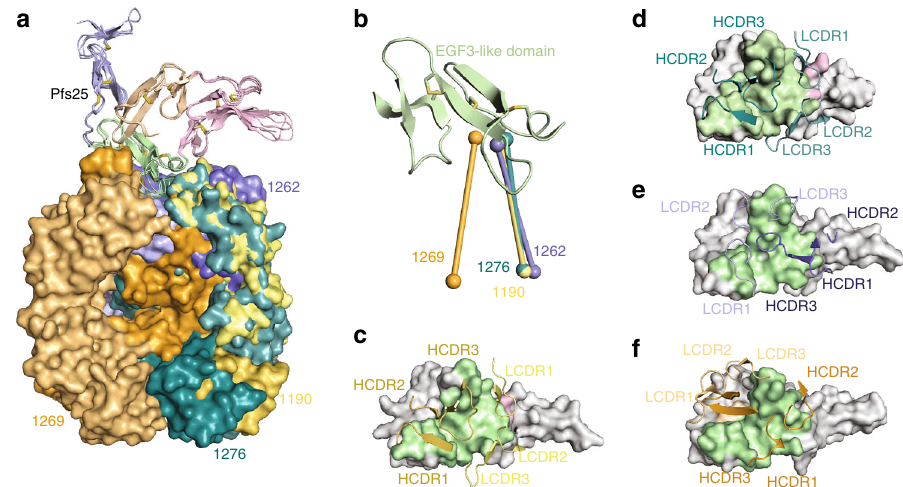
Fig. 4 Molecular details of site 1a antibody recognition. a Superposition of site 1a antibody – Pfs25 co-complex crystal structures. Pfs25 ’ s are shown as cartoon and colored according to EGF-like domain as in Fig. 3. 1190, 1262, 1269, and 1276 Fabs are shown as surface representation and colored in yellow, blue, orange, and teal, respectively. b Comparison of the angle of approach. The center of mass for both the Fab variable domains and interacting Pfs25 residues are shown as spheres and colored as in a . CDR loops that interact with Pfs25 for c 1190, d 1276, e 1262, and f 1269. Non-interacting Pfs25 residues are colored gray, while interacting residues are colored according to their EGF-like domain as in a